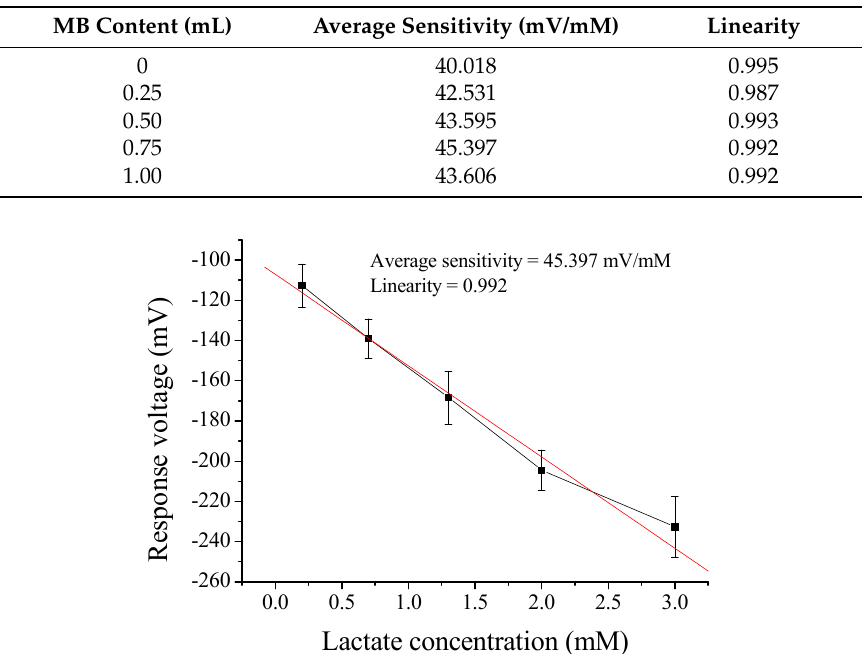
Table 2. The average sensitivity and linearity for flexible arrayed lactate biosensors modified by different magnetic beads (MB) contents.